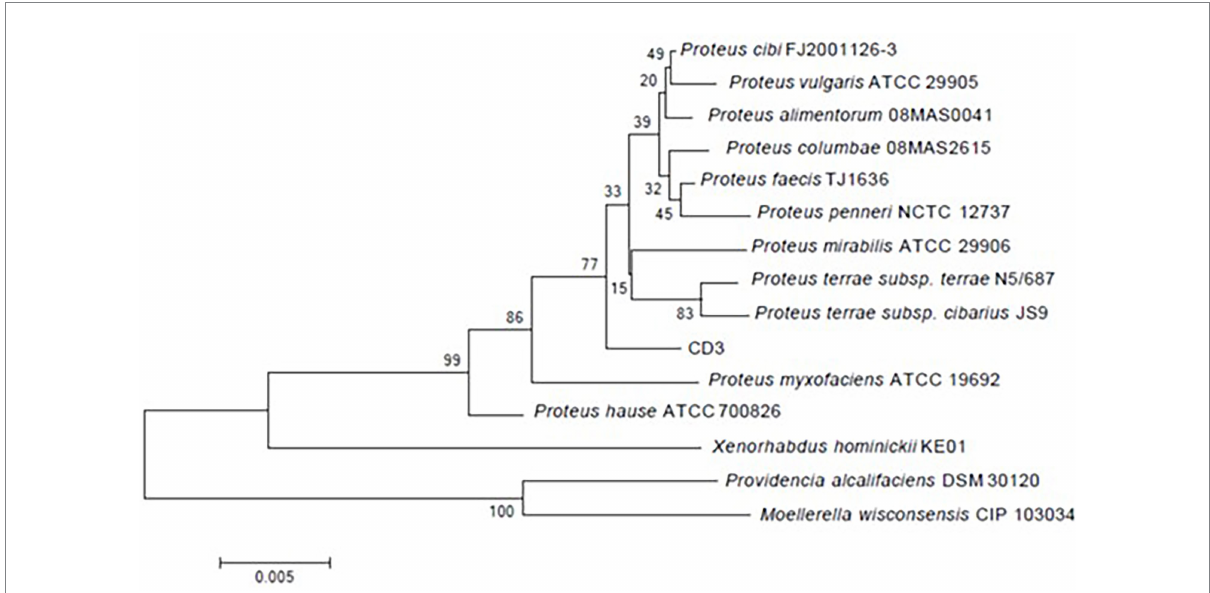
FIGURE 2 Phylogenetic tree constructed on the basis of 16S rRNA gene sequence of strain CD3 and other related species retrieved from the GenBank database according to neighbor joining. Bootstrap values obtained with 1,000 resamplings were indicated as percentages at all